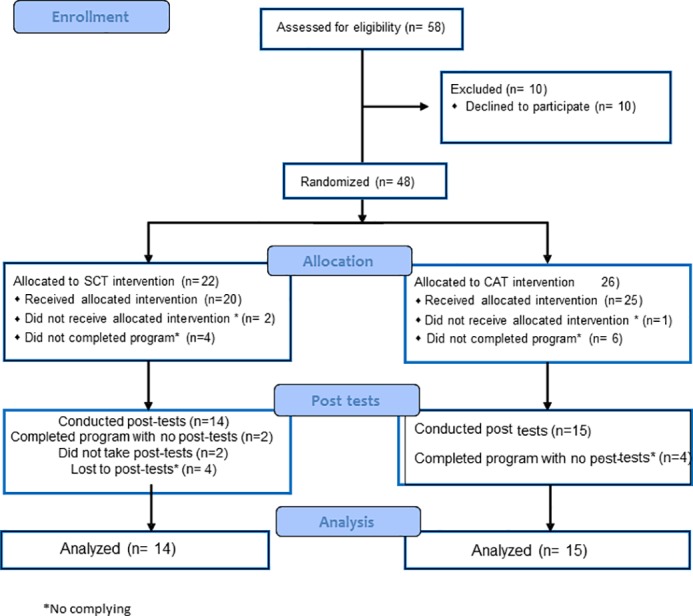
Study participant’s flow chart.